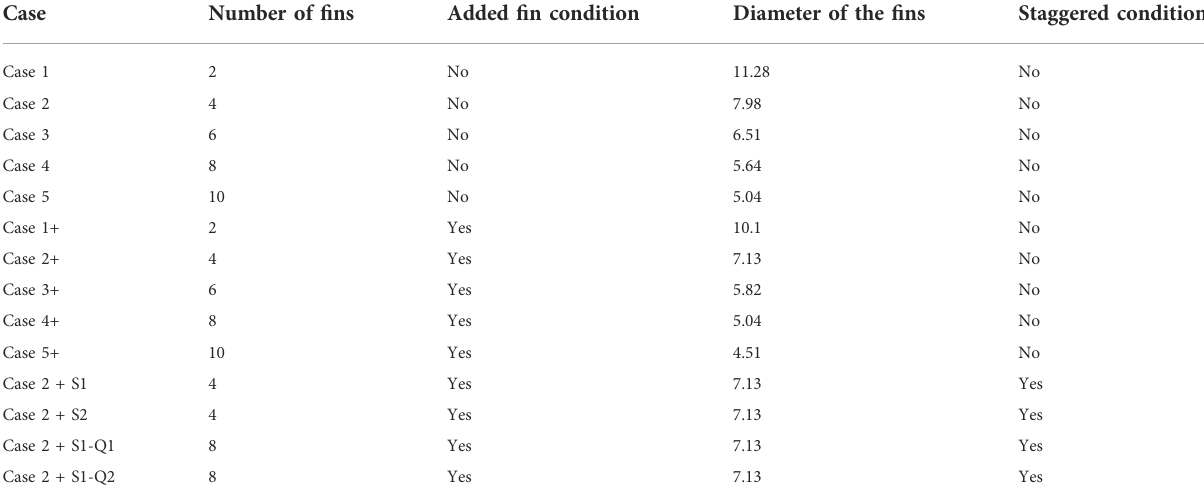
TABLE 1 Characteristics of different cases studied in this work.